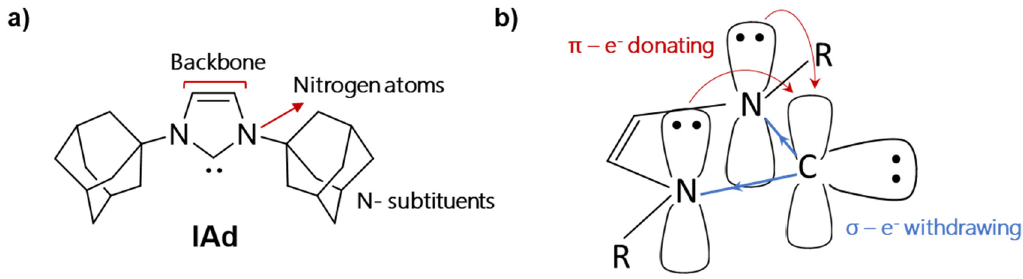
Figure 1. ( a ) First example of an isolated N -heterocyclic carbenes (NHC) ligand. ( b ) Electronic structure of an N -heterocyclic carbene ligand.